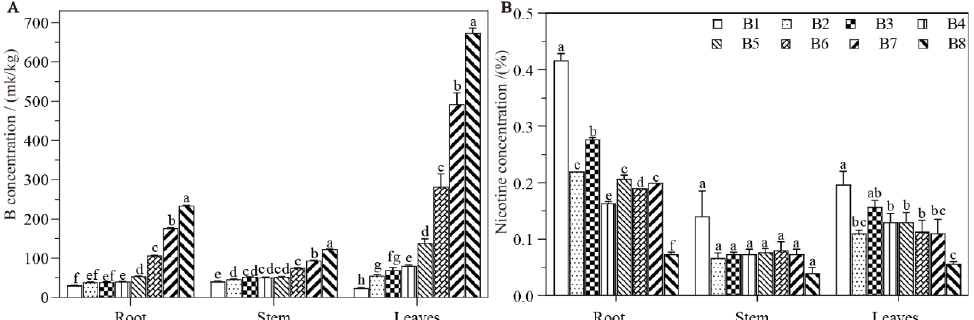
Figure 4. Changes of B and nicotine concentration in different parts of flue-cured tobacco under different B concentrations. Note: concentration of B and nicotine content in each part of tobacco seedlings under different B concentrations. ( A ) B concentration. ( B ) Nicotine concentration. Data are means ± standard errors ( n = 3). Within a column, values followed by different lower letters are significantly different at p < 0.05 following Duncan’s multiple-range test.